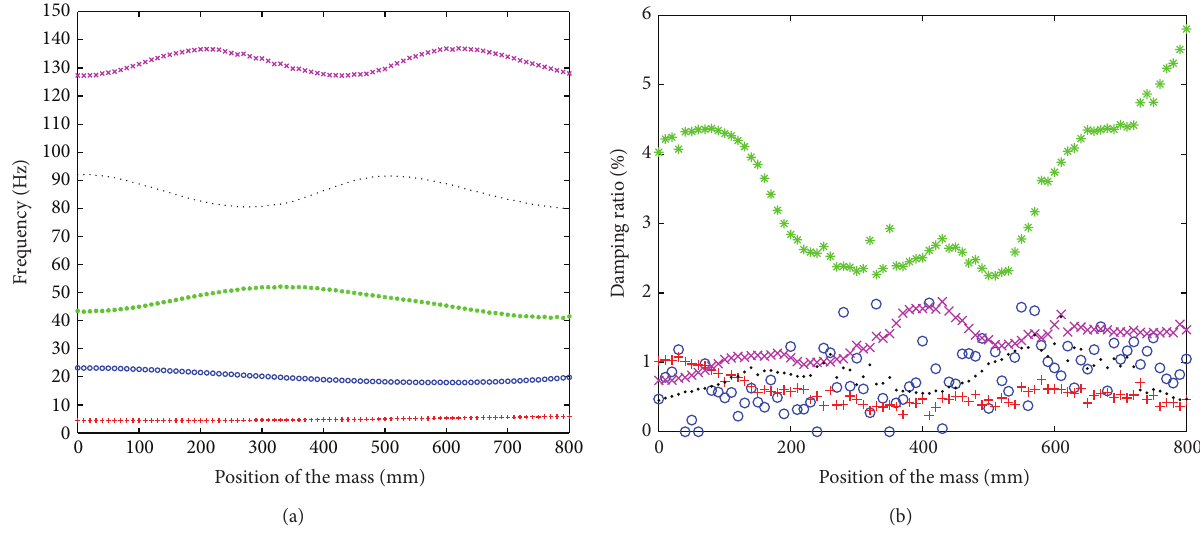
Figure 5: (a) Modal frequency. (b) Damping ratio for Mode 1 (“ ∙ ”), Mode 2 (“ × ”), Mode 3 (“ ∗ ”), Mode 4 (“+”), and Mode 5 (“ I ”).